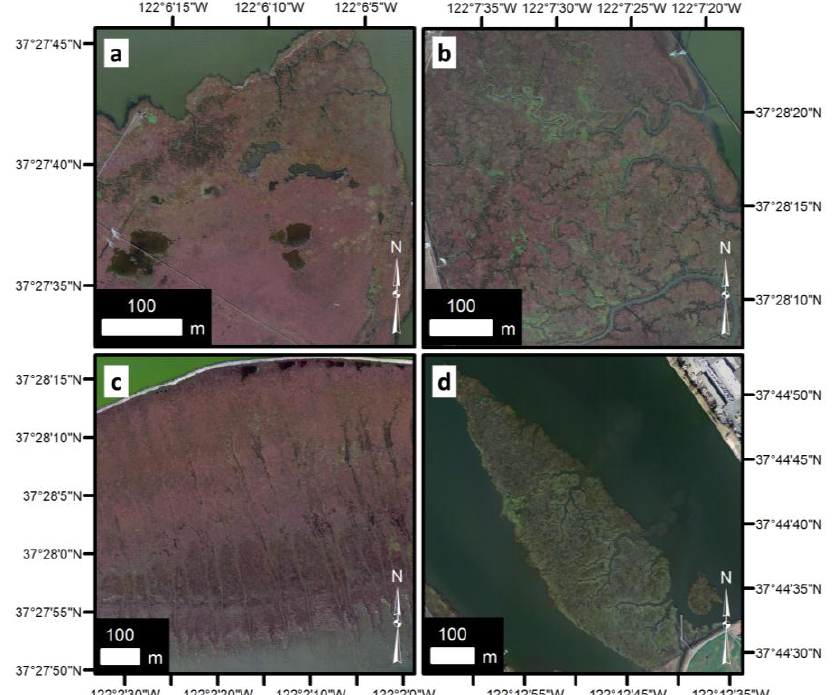
Figure 8. Salt marshes in San Francisco Bay. ( a ) Mature marsh with simple vegetation and channel patterns (Sand Point, Palo Alto); ( b ) Mature marsh with complex vegetation and channel patterns (Laumeister Tract, East Palo Alto); ( c ) Young marsh with simple vegetation and channel patterns (Arrowhead Marsh, Oakland); and ( d ) Young marsh with complex vegetation and channel patterns (Laumeister Tract, East Palo Alto). Aerial imagery from